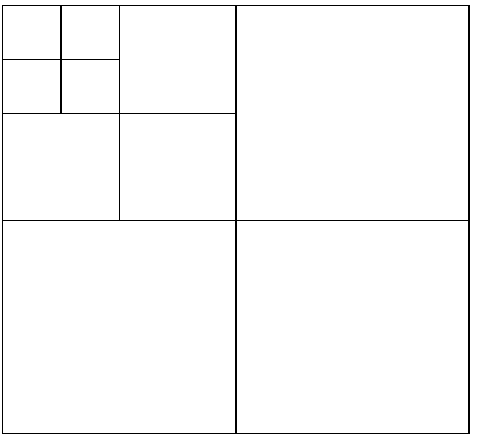
Figure 2. Scheme of dividing the ROI for quadtree decomposition.